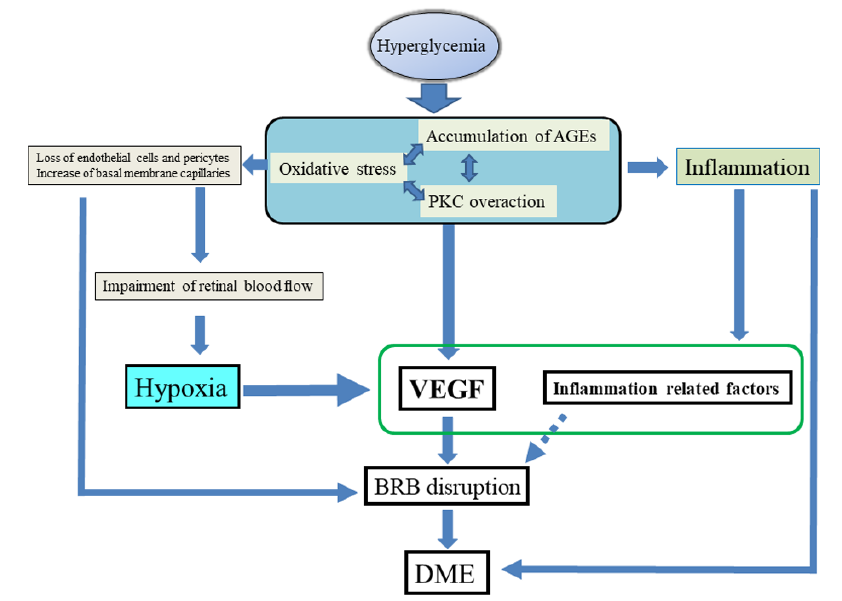
Figure 3. Hypothesized pathogenesis of diabetic macular edema. In diabetic macular edema (DME), hyperglycemia causes abnormalities of biochemical pathways, leading to both retinal hypoxia and inflammation. As a result, expression of vascular endothelial growth factor (VEGF) and inflammatory cytokines are increased, resulting in disruption of the blood–retina barrier (BRB) and development and progression of macular edema. Abbreviations: AGEs, advanced glycation end-products; PKC, protein kinase